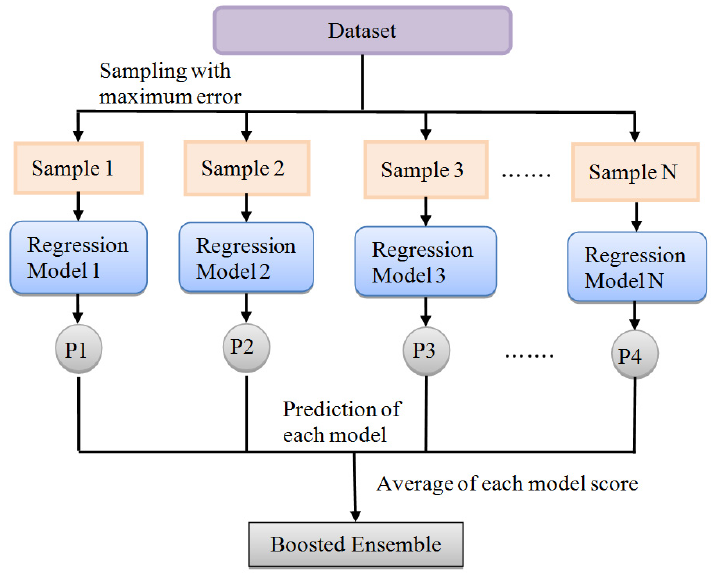
Figure 8. BTER method for